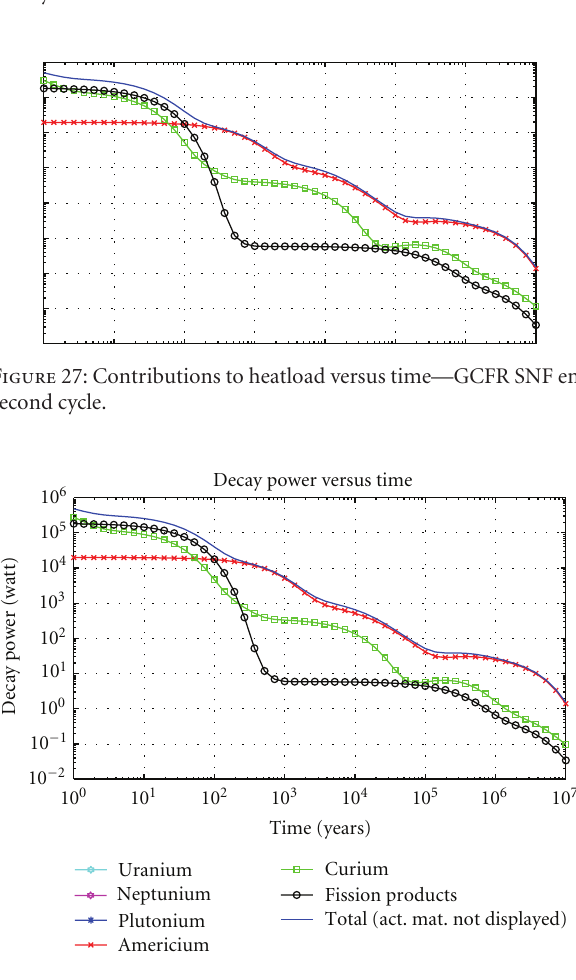
Figure 26: Contributions to heatload versus time—GCFR SNF end first cycle.